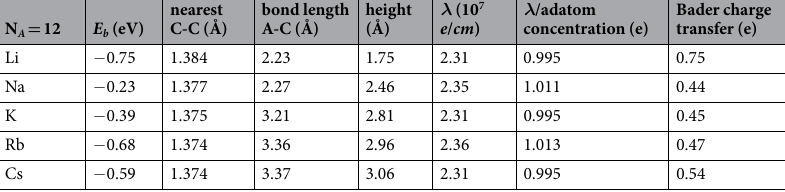
Table 1. Binding energies, bond lengths, heights, and free electron densities of N A = 12 alkali-adsorbed GNRs with one adatom in a unit